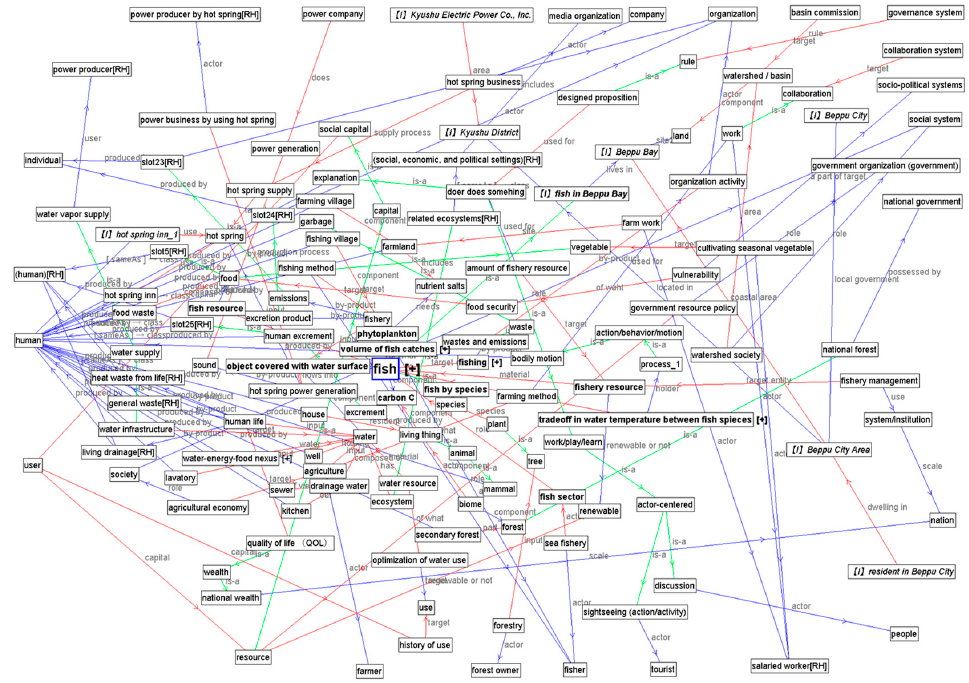
Figure 13. The “fish”–agent nexus system map.